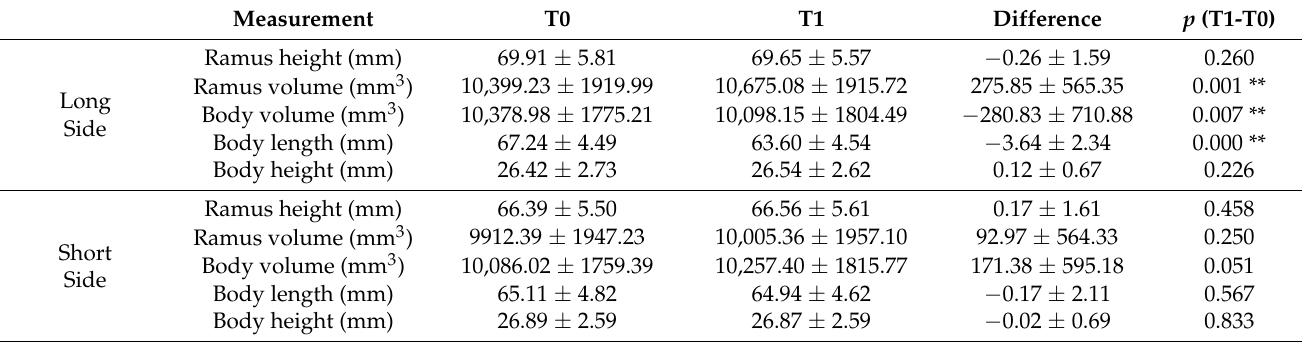
Table 3. Comparison of the mandibular morphology on the same side before (T0) and after surgery (T1) in patients with asymmetric mandibular